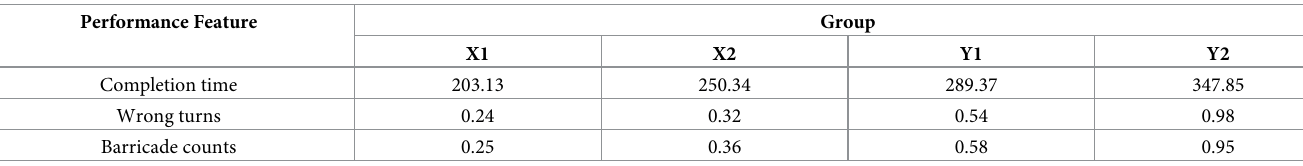
Table 2. Driving performance